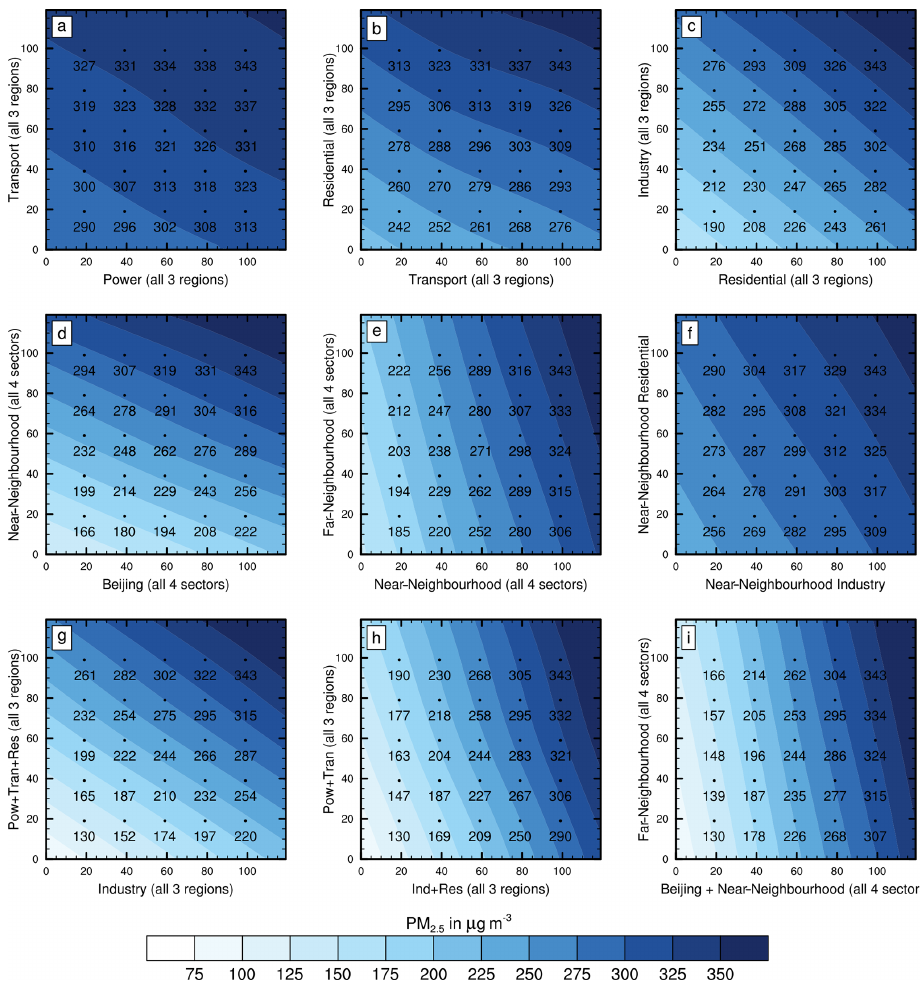
Figure 10. Response of daily mean PM 2 . 5 concentrations in Beijing (in µgm − 3 ) to changes in specific sectoral and regional emissions. Axes show the scaling applied to the relevant source (in %) starting on 21 October; contours show the corresponding daily mean PM 2 . 5 in Beijing on 24 October (concentrations at 20% intervals are labelled for